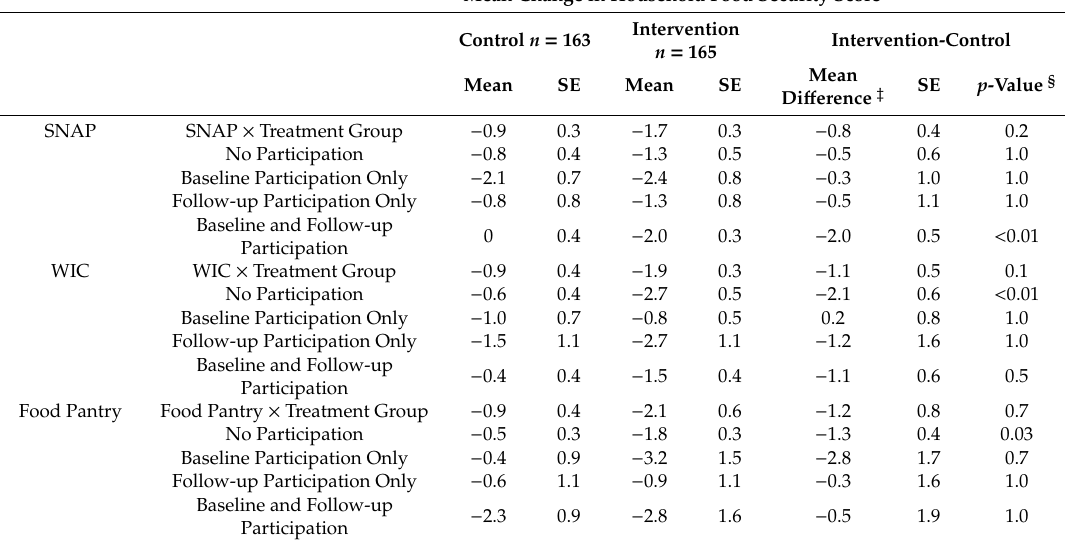
Food Pantry Food Pantry × Treatment Group −